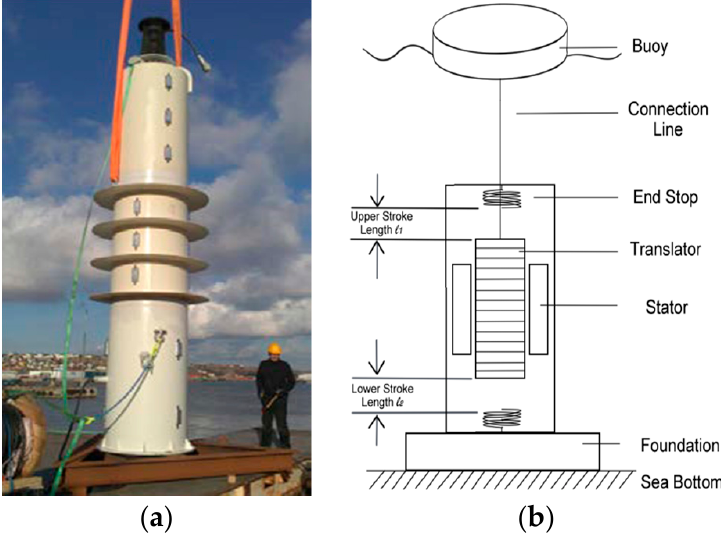
Figure 1. Illustration of the wave energy converter (WEC) device developed in Lysekil Project: ( a ) one of the WEC prototypes L12 was assembled at the harbor; and ( b ) a simplified mechanical structure of a direct ‐ drive type WEC